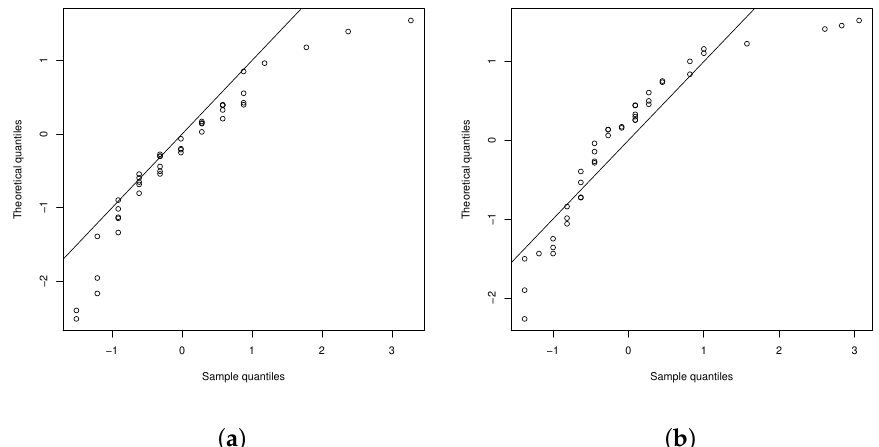
Figure 2. QQ-plots for SHN models. ( a ) CO 2 and ( b ) O 3 .